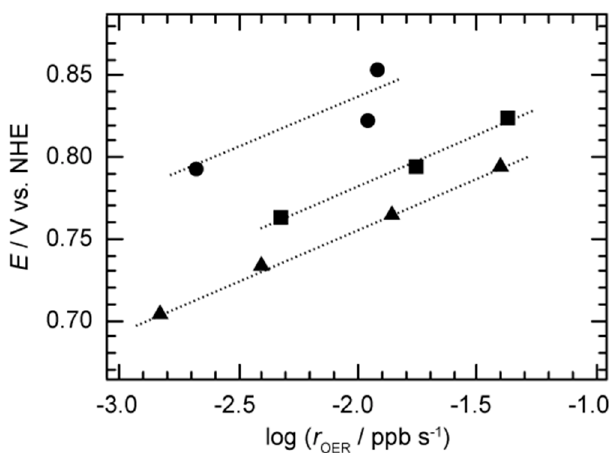
Figure 3. Tafel plot of logarithm reaction rate of OER ( r OER ) versus electrochemical potential ( E ) under oxygen evolution condition from F–carbon. The data were recorded at pH 13 (circle), pH 13.5 (square), and pH 14 (triangle). Values of r OER were evaluated from the slope of concentration of oxygen versus time: d C O /d t .